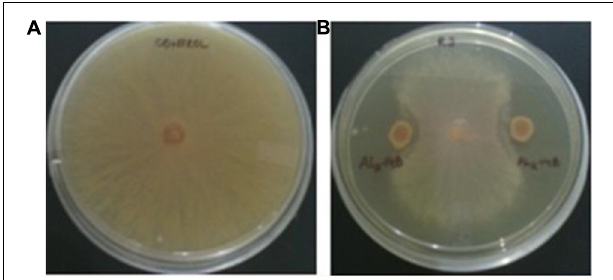
FIGURE 4 | Antagonistic activity of AL2-14B. (A) Control, (B) dual culture assay for assessment of mycelial growth inhibition of Rhizoctonia solani by AL2-14B.